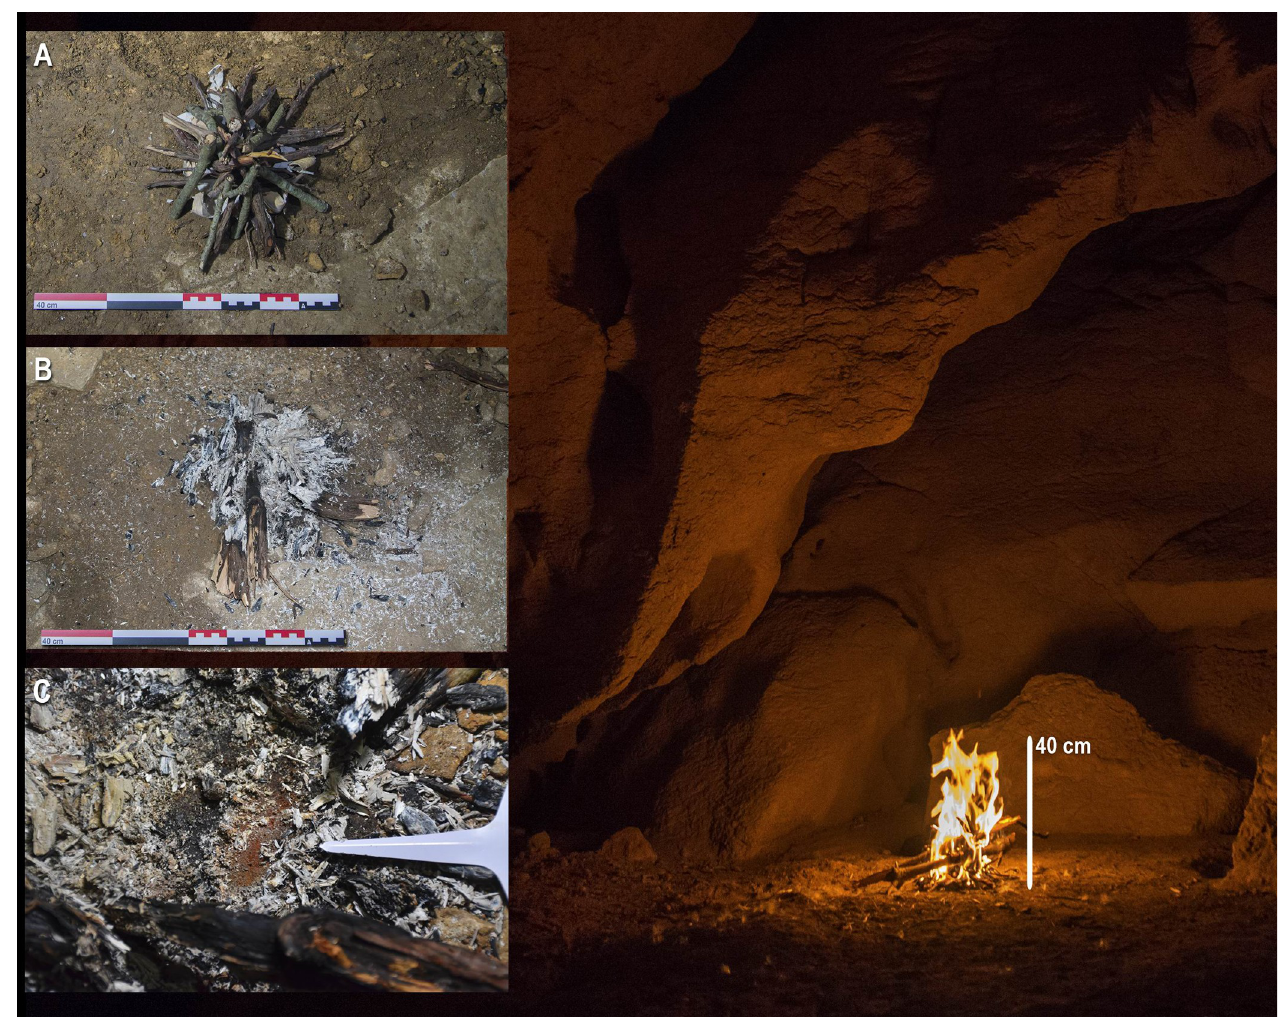
Fig 8. Photograph during experiment 8. A. Experiment 8 before combustion; vertical view. B. Experiment 8 after putting out the fireplace. C. Experiment 8 after the extinction of the fireplace, showing a detail of the rubefaction under the ashes.